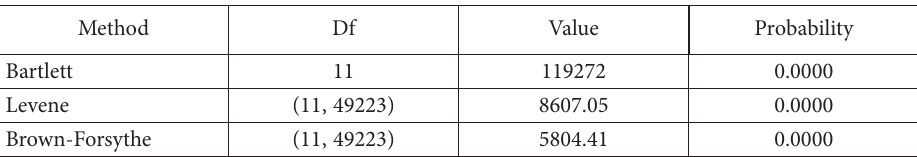
Table 6. Homoscedasticity test